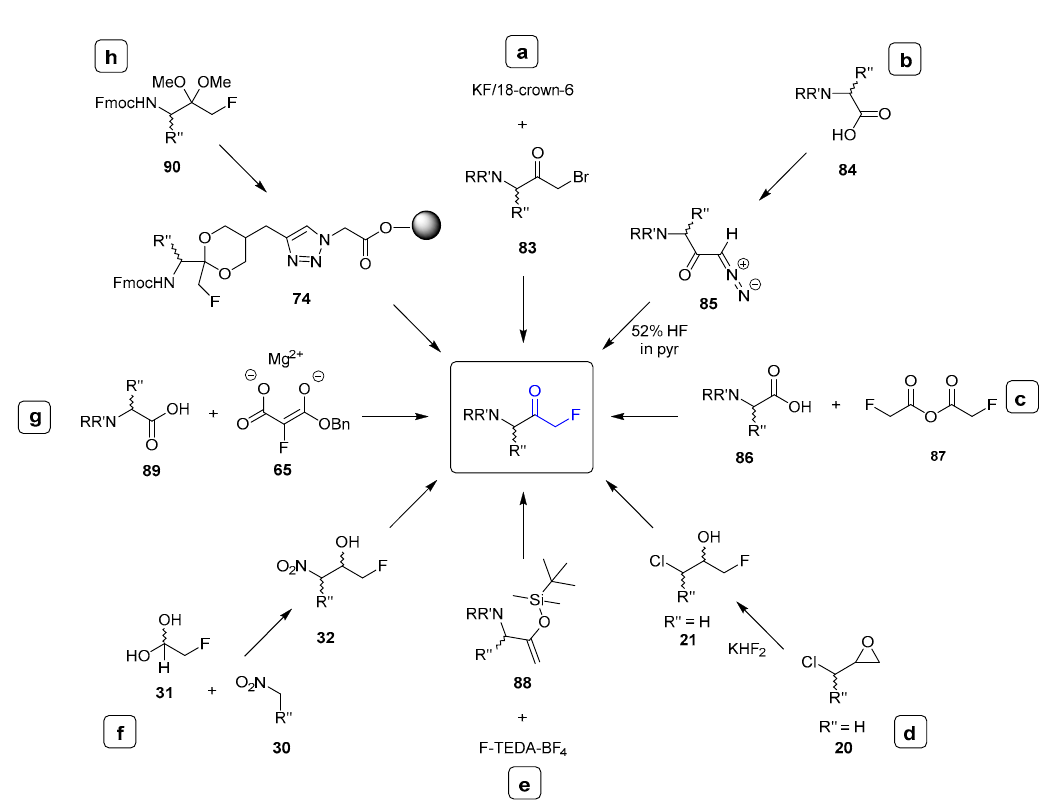
Figure 7. Summary of current solid- and solution-phase synthetic routes for accessing peptidyl mono-fluoromethyl ketones (FMKs).